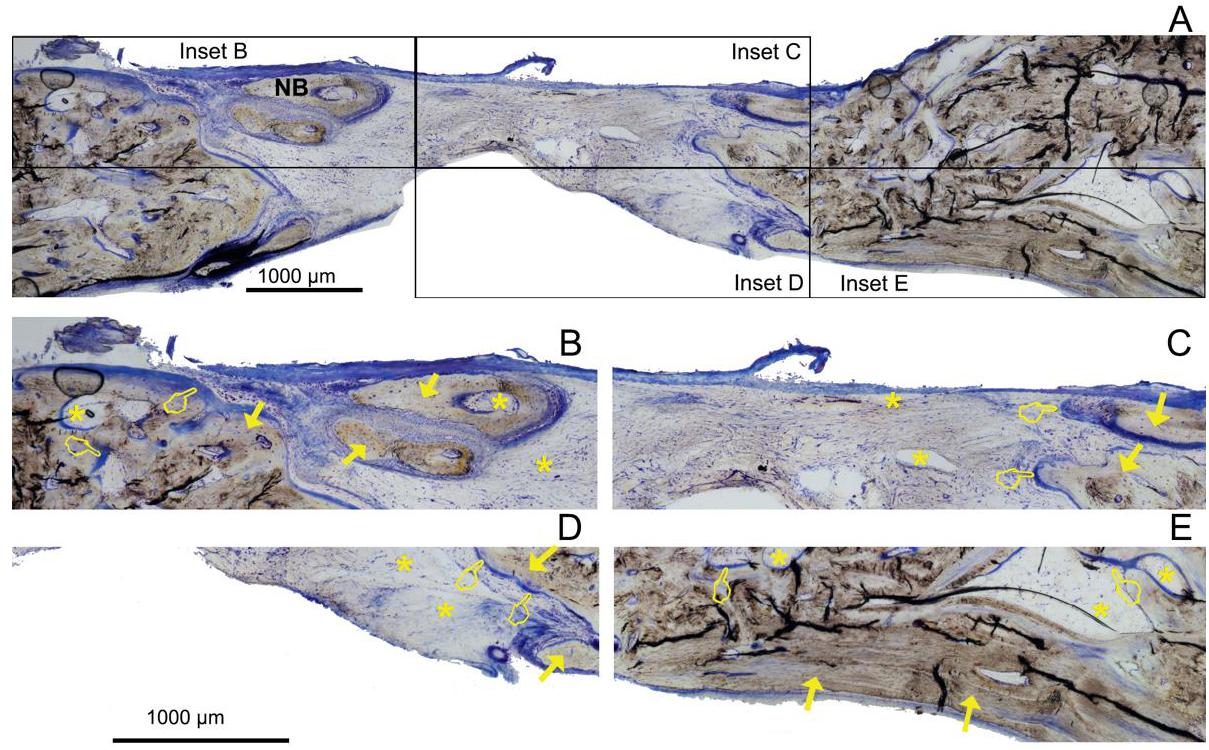
Figure 3. Bone histology obtained after using HOOC-Si-loaded membranes dyed with toluidine blue to visualize mineralized bone at 6 weeks of healing time. Single arrows point to the presence of new bone area (NBA). Osteoid area (OA) is signaled by pointers, and soft tissue area (STA) is indicated by asterisks. ( A ) General view. NB—new bone. Insets AB, AC, AD, and AE reflect the corresponding areas analyzed in Figure 3B–E; ( B ) indicates a partial view of R1 area (top left); ( C ) R2 (top central); ( D ) R5 (bottom central); and ( E ) R6 (bottom right). ( B ) shows an extended area of homogeneous fringe in a clear blue color between the aligned osteoblasts and the mature bone (the osteoid bone at R1). ( C ) permits the observation of the osteoid bone when first deposited and not yet mineralized, signaling the zone where the new bone is growing through at R2. ( D ) reveals the lowest NBA value and the highest STA value that were observed in R5. ( E ) A new bone base at the bottom right of the defect was created next to the dura mater in